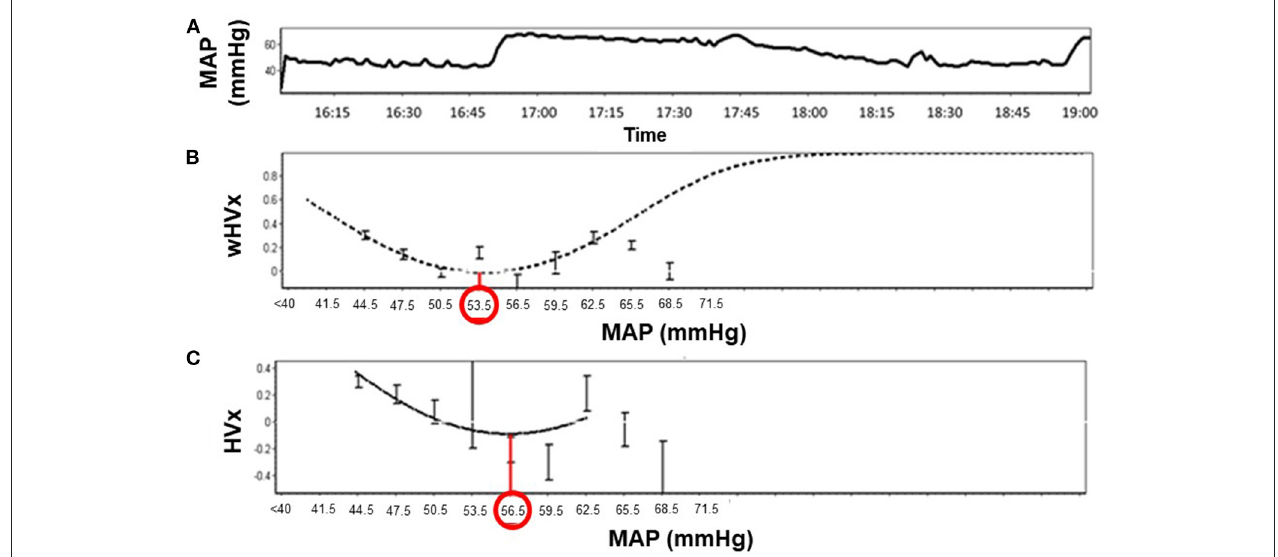
FIGURE 2 | Identification of optimal mean arterial blood pressure (MAPopt) by the hemoglobin volume index (HVx) and the wavelet hemoglobin volume index (wHVx) in an example neonate. (A) Mean arterial blood pressure; (B) Using wHVx, the curve fitting method identified MAPopt at 53.5 mmHg. (C) HVx identified MAPopt at 56.5 mmHg. The curved lines show the optimal curve fit applied by ICM + software. The bars are standard deviations.